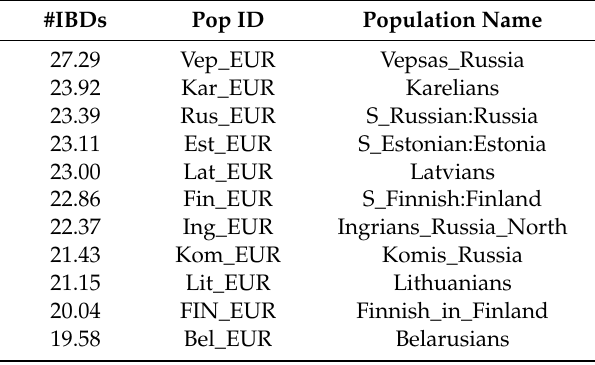
Figure 1. Heat map for the Table S1. Blue color—no genetic relatedness between populations, red—the highest relatedness. The scale represents numbers of IBD fragments per pair of individuals from 0 (dark blue) to 300 (red). AFR—Africa; AMR—America; ARC—Arctic; CAS—Central Asia; CAU—Caucasus; EUR—Europe; EAS—East Asia; SAS—South Asia; OCE—Oceania and Australia; MDE—Middle East; SIB—Siberia; XXX—archaic and prehistoric modern humans described in the Section 5. Table 2. Example of ranking data for numbers of shared IBD fragments for Russian population (identifier: Rus_EUR ).